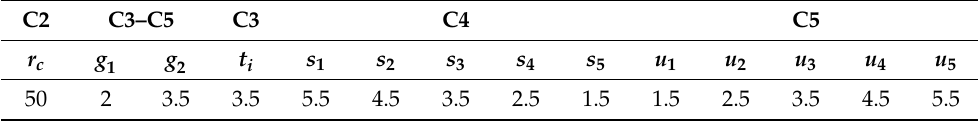
Table 5. Different structural parameters of C2–C5 (units: μm ).